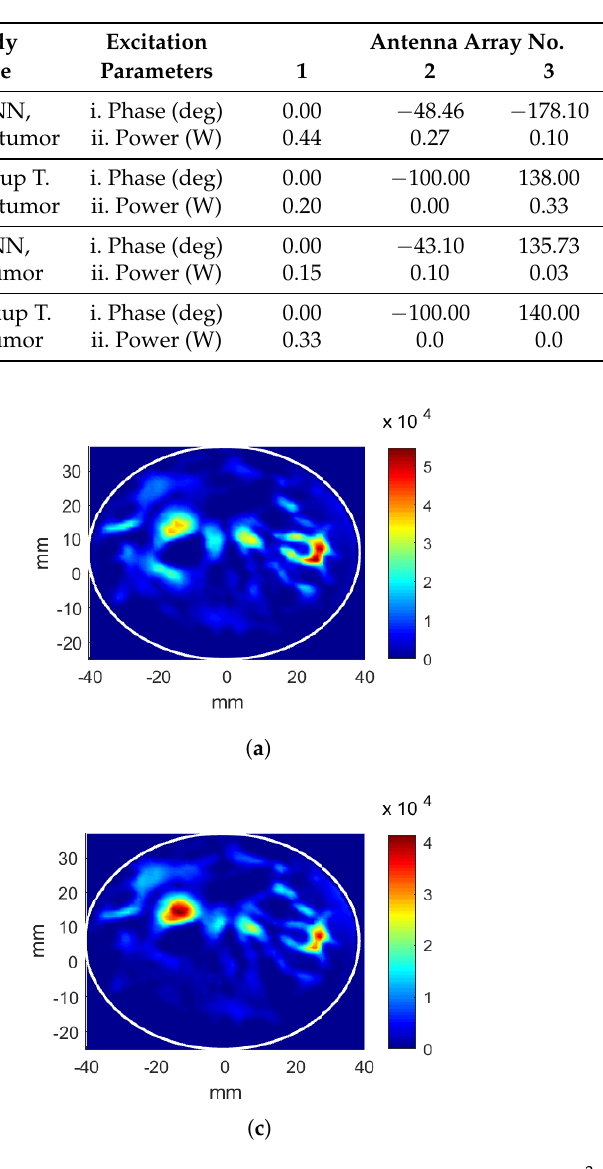
Figure 4. Heating potential (Wm − 3 ) distributions for the linear antenna system and the breast without a tumor, target at (26, 12, 0) mm position. Parameters obtained from CNN: ( a ) phase-only optimization, ( b ) phase and power optimization. Excitation parameters obtained from look-up table: ( c ) phase-only optimization, ( d ) phase and power